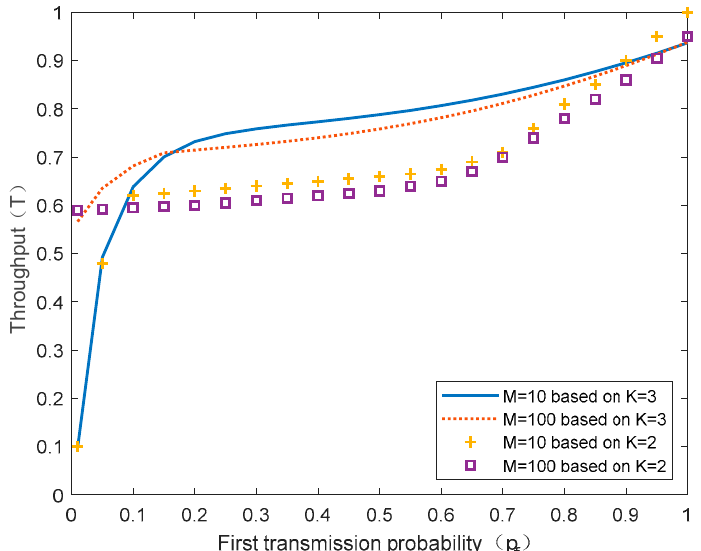
Figure 13. Throughput vs. first transmission probability ( K = 3 in our model vs. K = 2 in reference [11]).